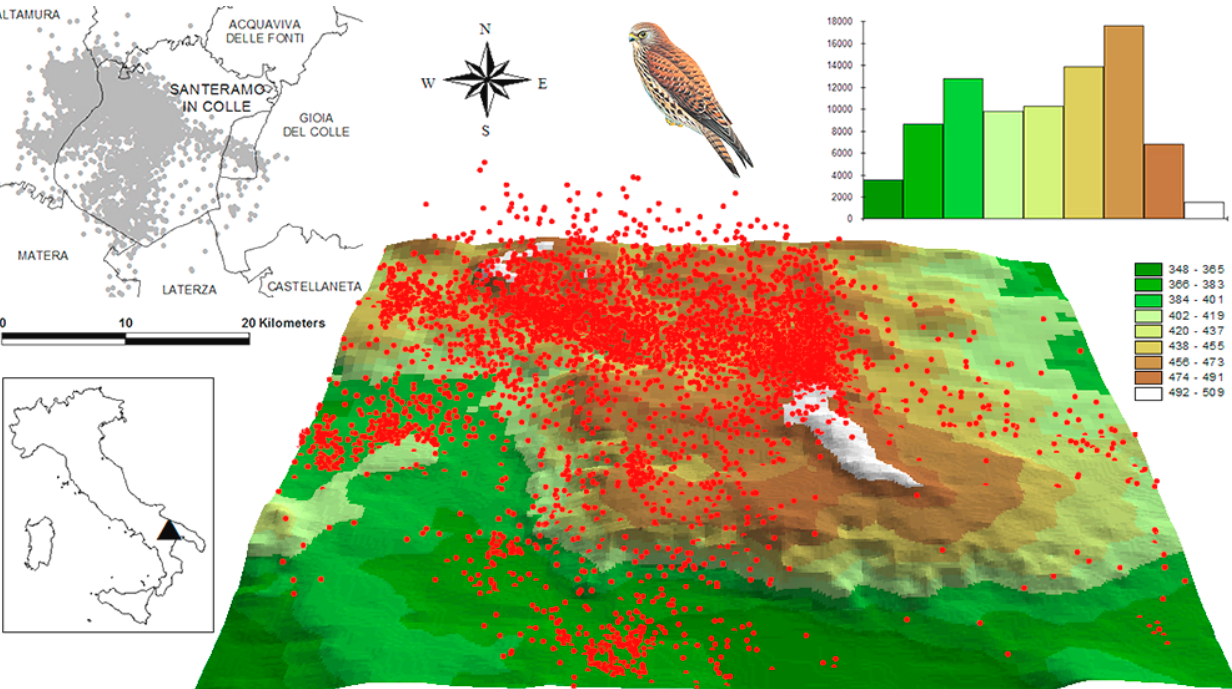
Figure 1. Study system. Top left: 2D map of the study area and GPS data (12,081 points in grey). Top right: elevation map histogram (X-axis: 9 equal-interval categories; Y-axis: number of GIS pixels; 1 pixel = 50 m × 50 m) of the study area. Centre: 3D representation of the topographic surface and GPS data (in red).